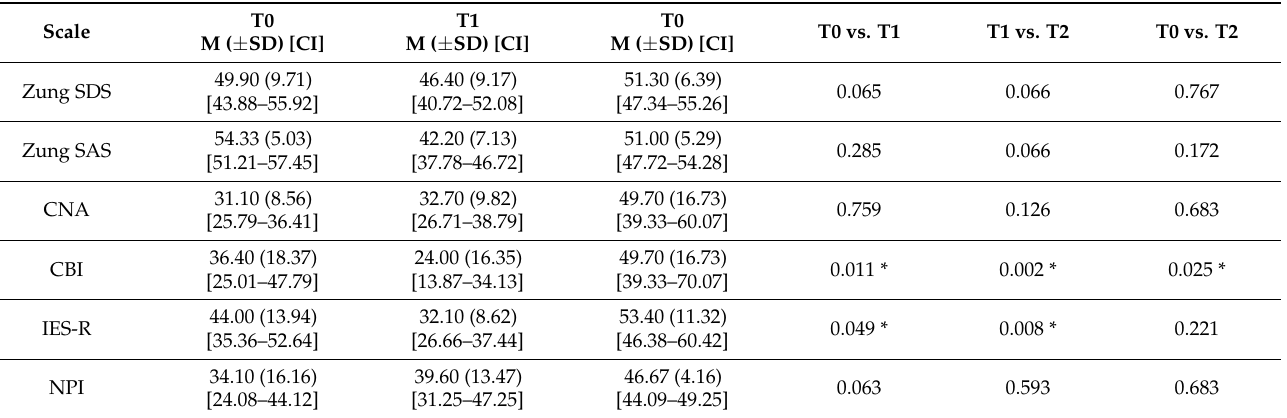
Table 3. Longitudinal assessment of measures of caregivers’ depression, anxiety, needs, burden, post-traumatic stressand neuropsychiatric symptoms in the TG.